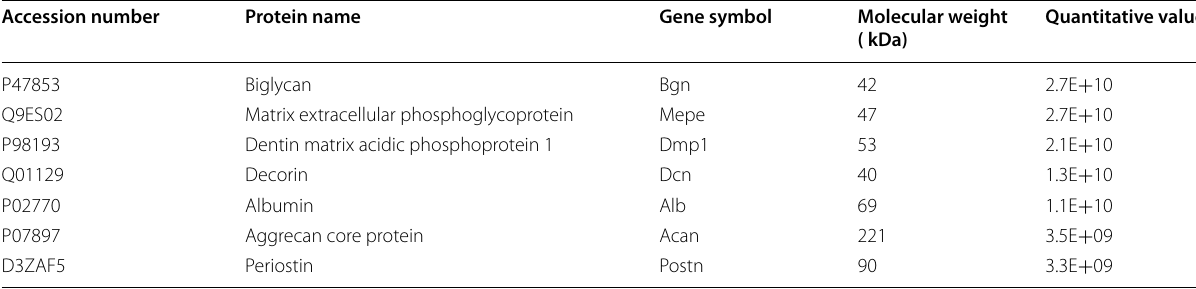
Detected proteins are listed in order of increasing quantification